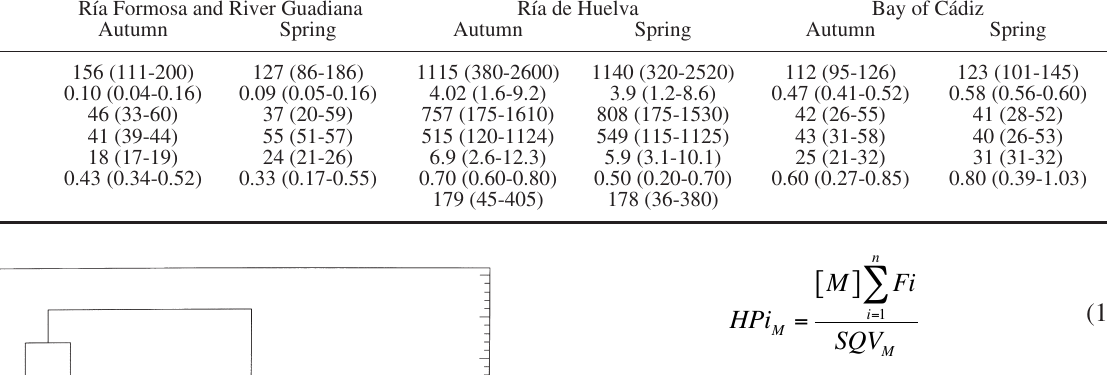
as µg g -1 dry weight.